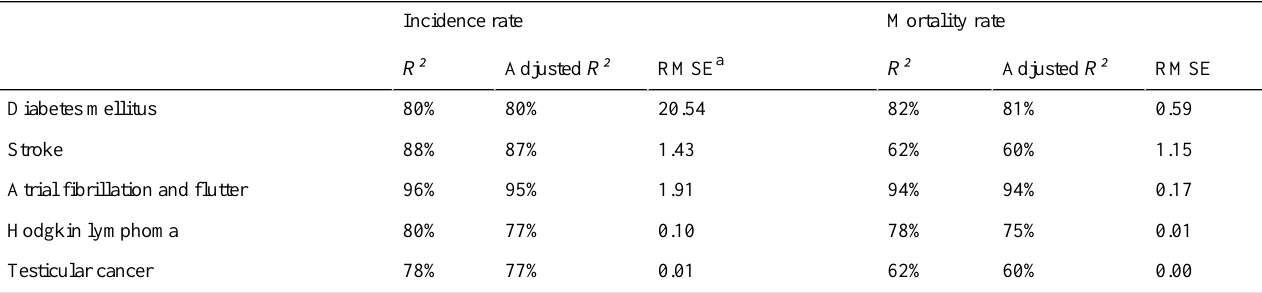
Table 2. Evaluation results of prediction models.